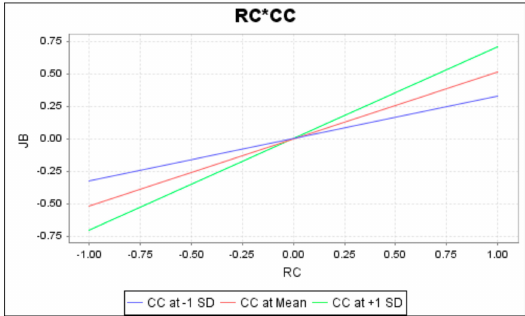
Figure 4. Moderation of career calling on the relationship between role conflict and job burnout.